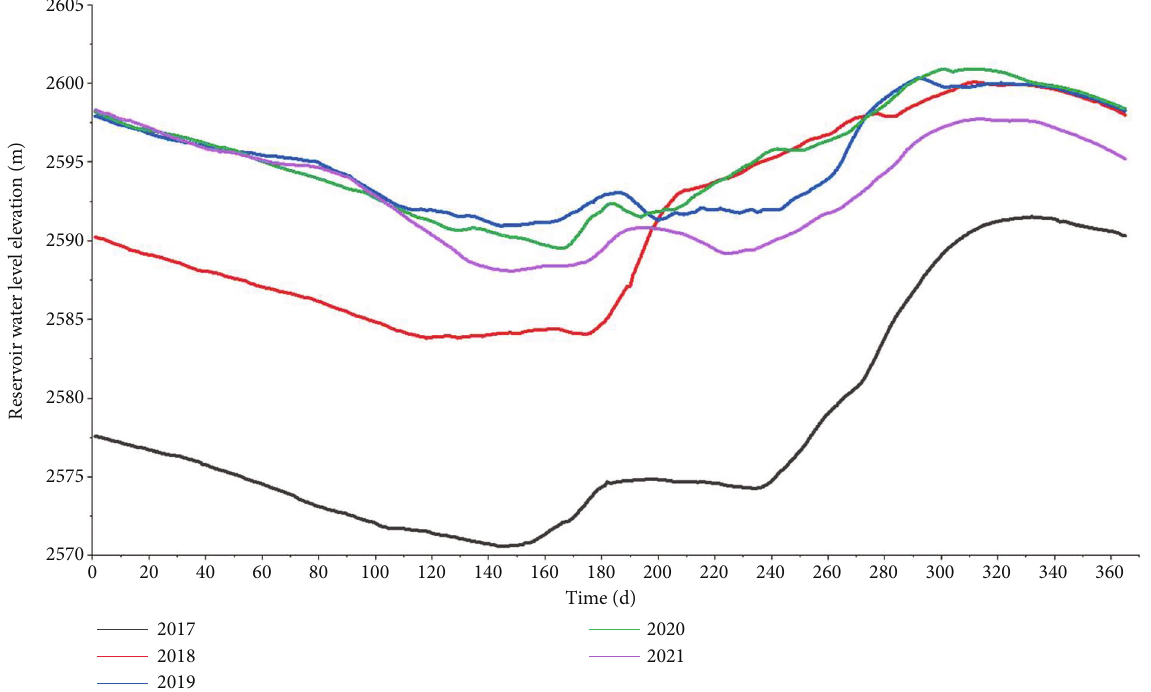
Figure 5: Changes of reservoir water level and elevation of Longyangxia Hydropower Station in recent fi ve years.